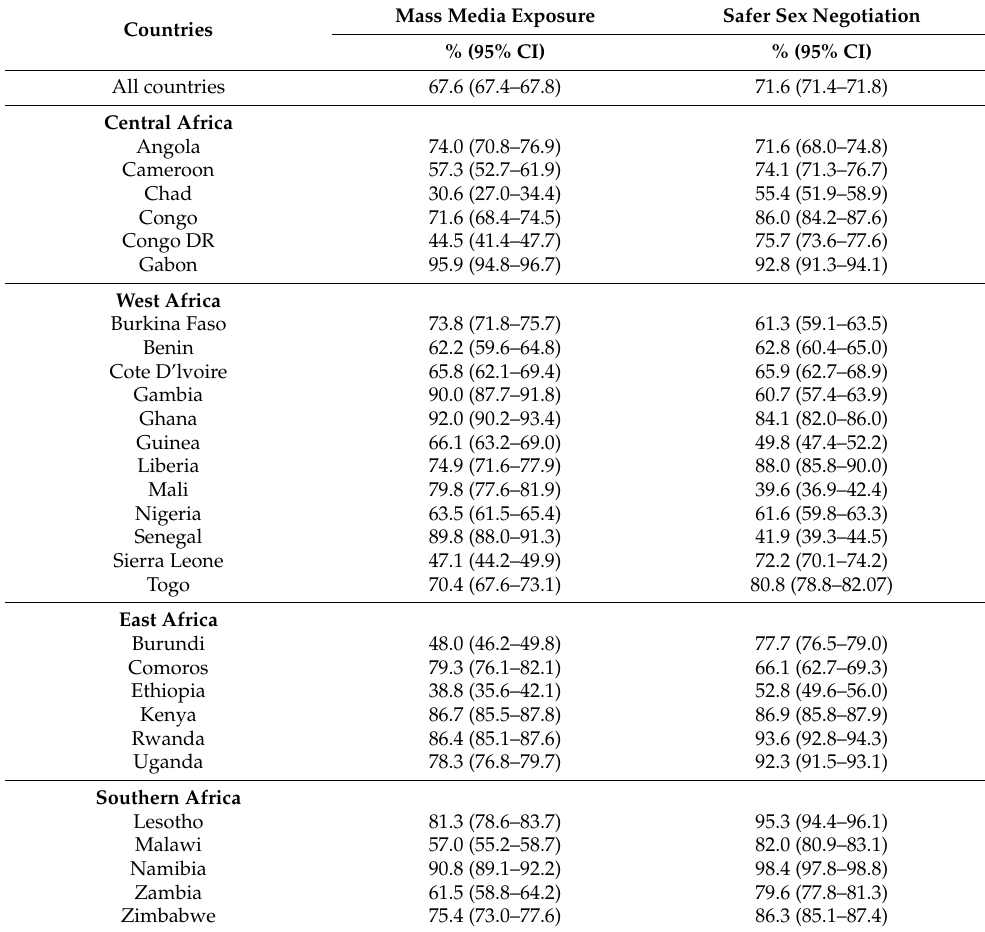
Table 2. Proportion of women in sexual unions who are exposed to mass media and can negotiate for safer sex negotiation in sub-Saharan